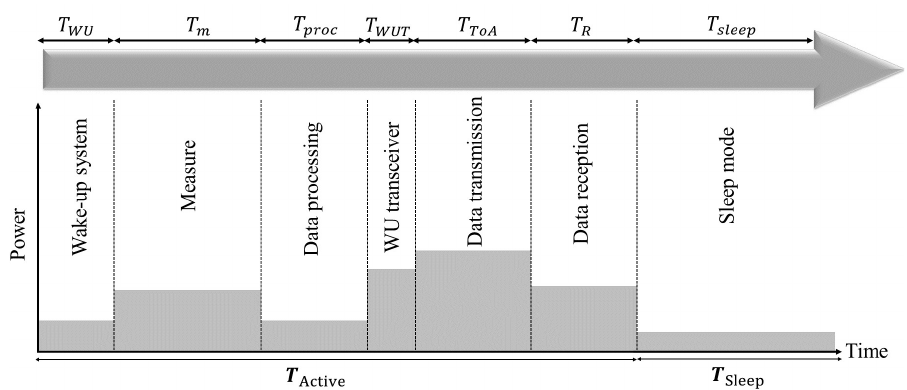
Figure 3. The assumed working mode sequence for each ED, adopted from